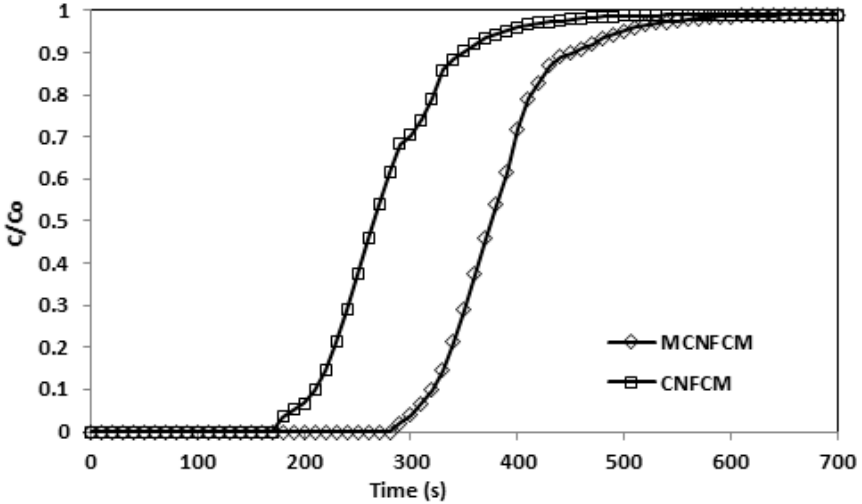
Table 12. CO 2 adsorption of CNFCM and modified CNFCM.